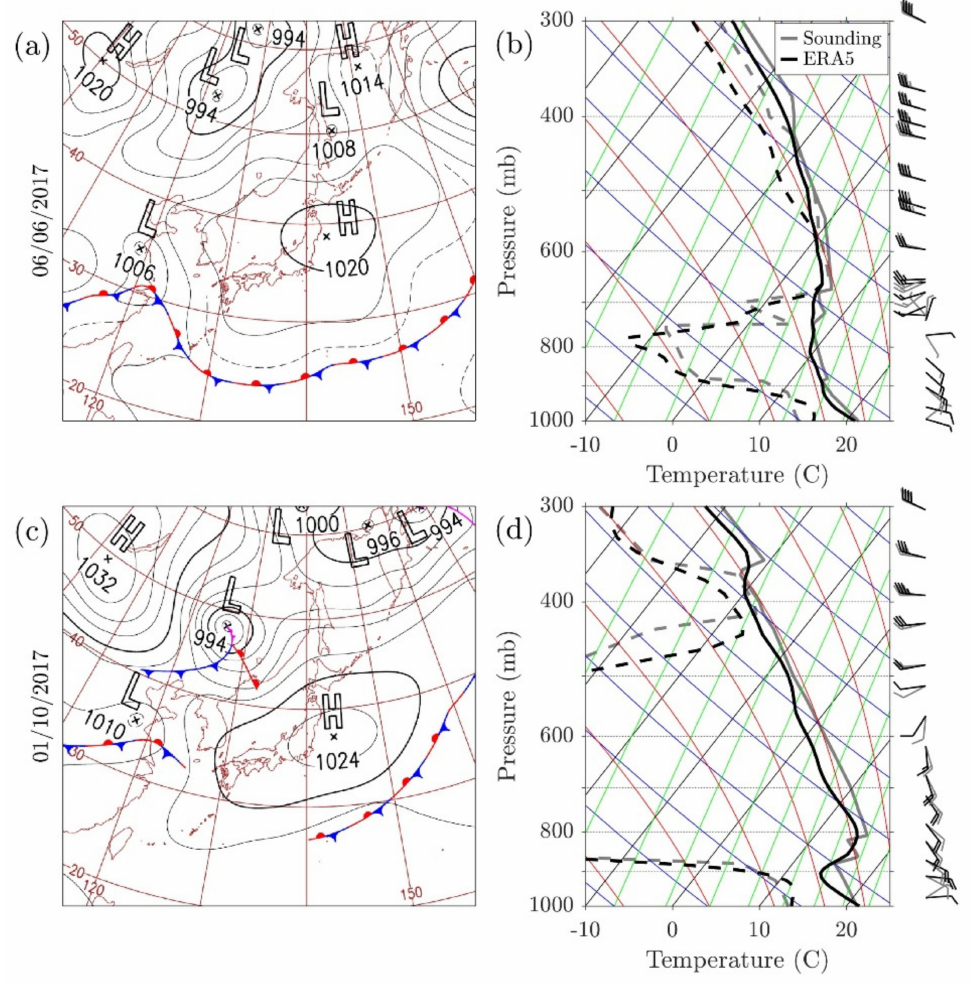
Figure 3. ( a , c ) Synoptic map published by the Japan Meteorological Agency (JMA) and ( b , d ) Skew–T plot based on sounding (gray) and European Reanalysis 5 (ERA5) reanalysis (black) data at 0900JST on 06/06/2017 (June case; first row) and 01/10/2017 (October case; second